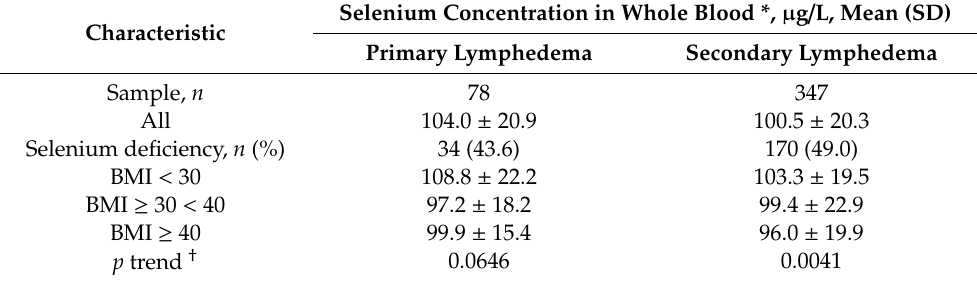
Table 2. Selenium concentration in